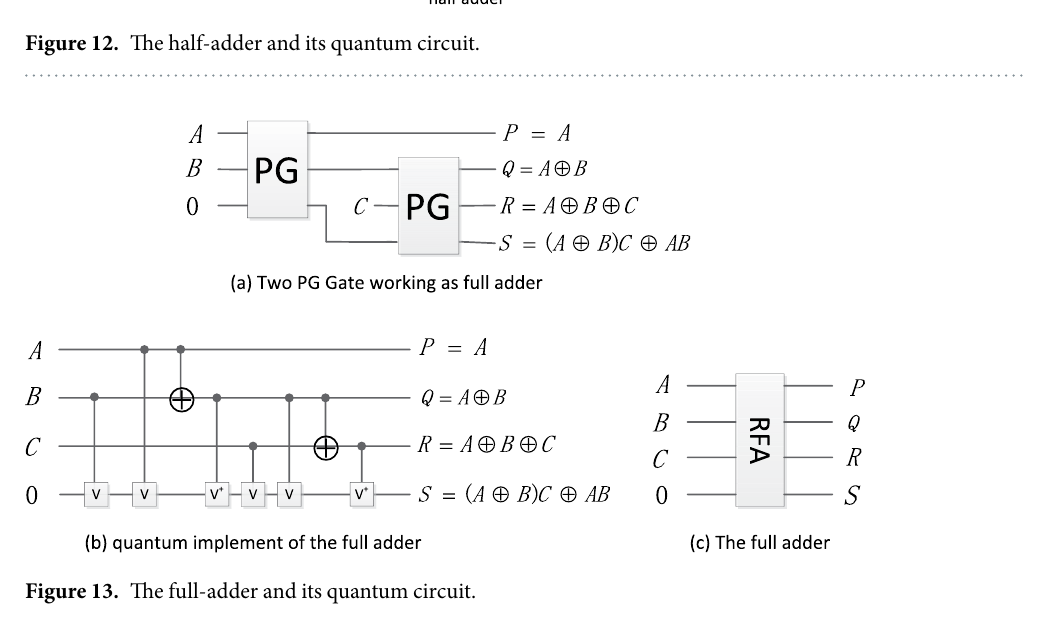
Figure 13. The full-adder and its quantum circuit.